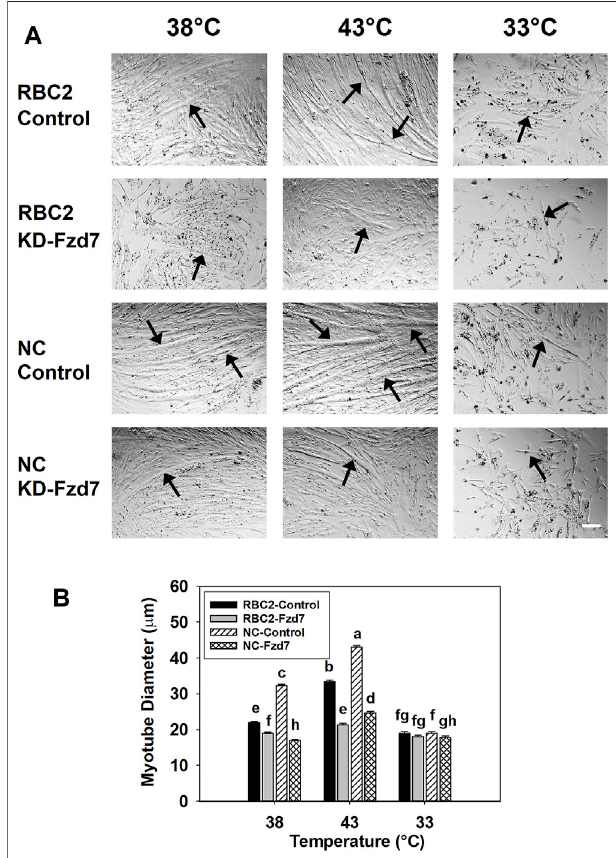
FIGURE 3 | Effect of hot and cold thermal stress and knockdown of frizzled-7 ( Fzd7 ) at the beginning of proliferation on myotube diameter. (A) RepresentativephotomicrographsofRandombred ControlLine2(RBC2)and modern commercial (NC) line SCs transfected with either a negative control siRNA (Control) or a siRNA targeting Fzd7 (KD-Fzd7) at the beginning of proliferation and followed for 72 h of proliferation and 48 h of differentiation at 38 ° C, 43 ° C, or 33 ° C. (B) Diameter of myotubes in each treatment group. Each graph bar represents a mean diameter of the myotubes, and each error bar representsa standard error of the mean. Mean values with different letters are signi fi cantly different ( p ≤ 0.05). Black arrows highlight representative myotubes. Scale bar (White) = 100 μ